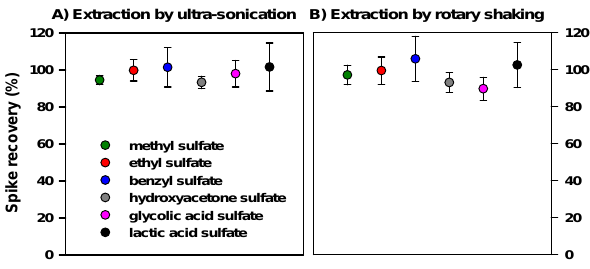
Figure 3. Comparison of spike recovery (%) (100µgL − 1 , n = 7 each) extracted by (a) ultra-sonication and (b) rotary shaking.